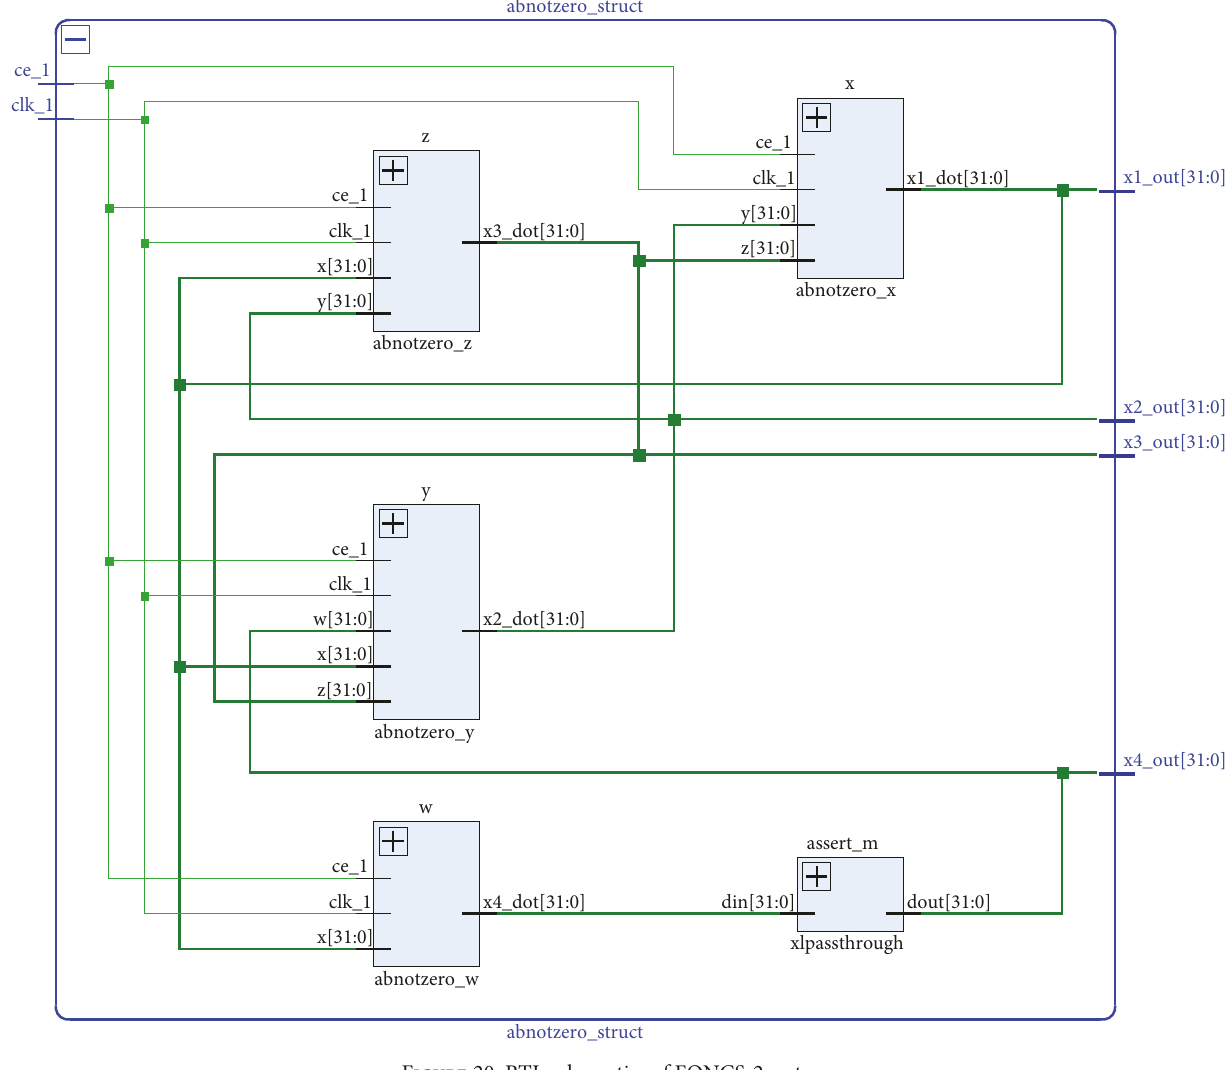
Figure 20: RTL schematics of FONCS-2 system.